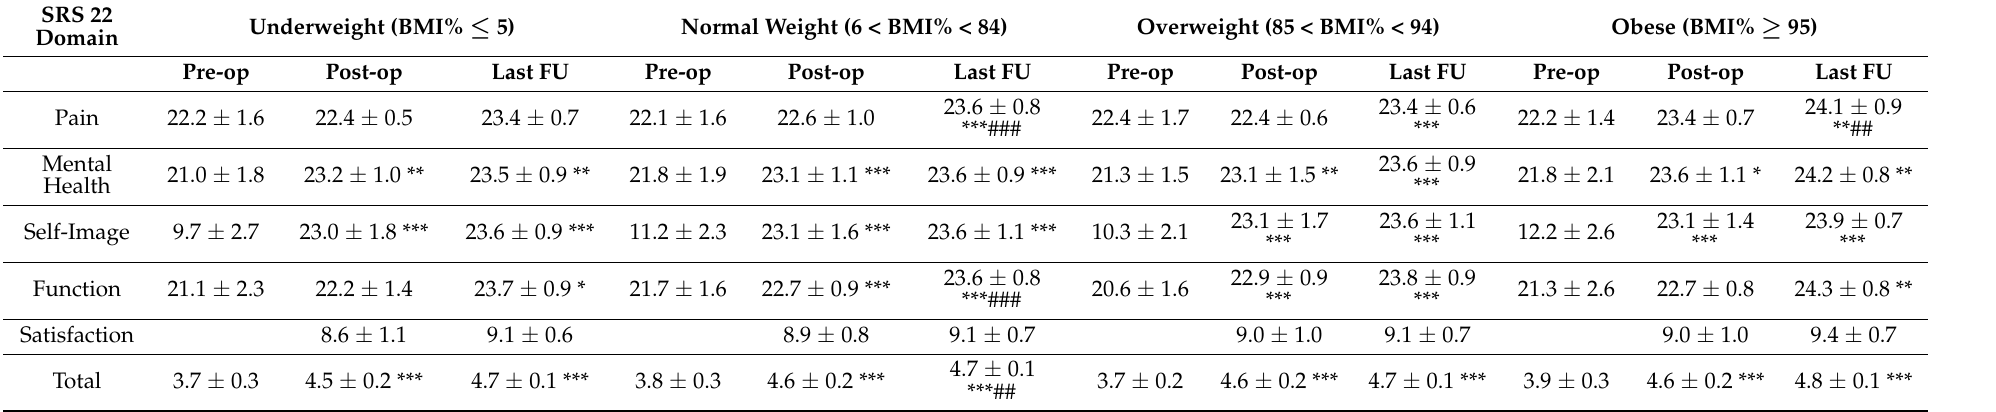
Table 3. SRS22 scores in the different BMI groups: * p < 0.05, ** p < 0.01, *** p < 0.001 vs. pre-op; ## p < 0.01, ### p < 0.001 vs. post-op. Statistical test: two-way ANOVA for repeated measures with post hoc pairwise t test with Bonferroni’s correction.